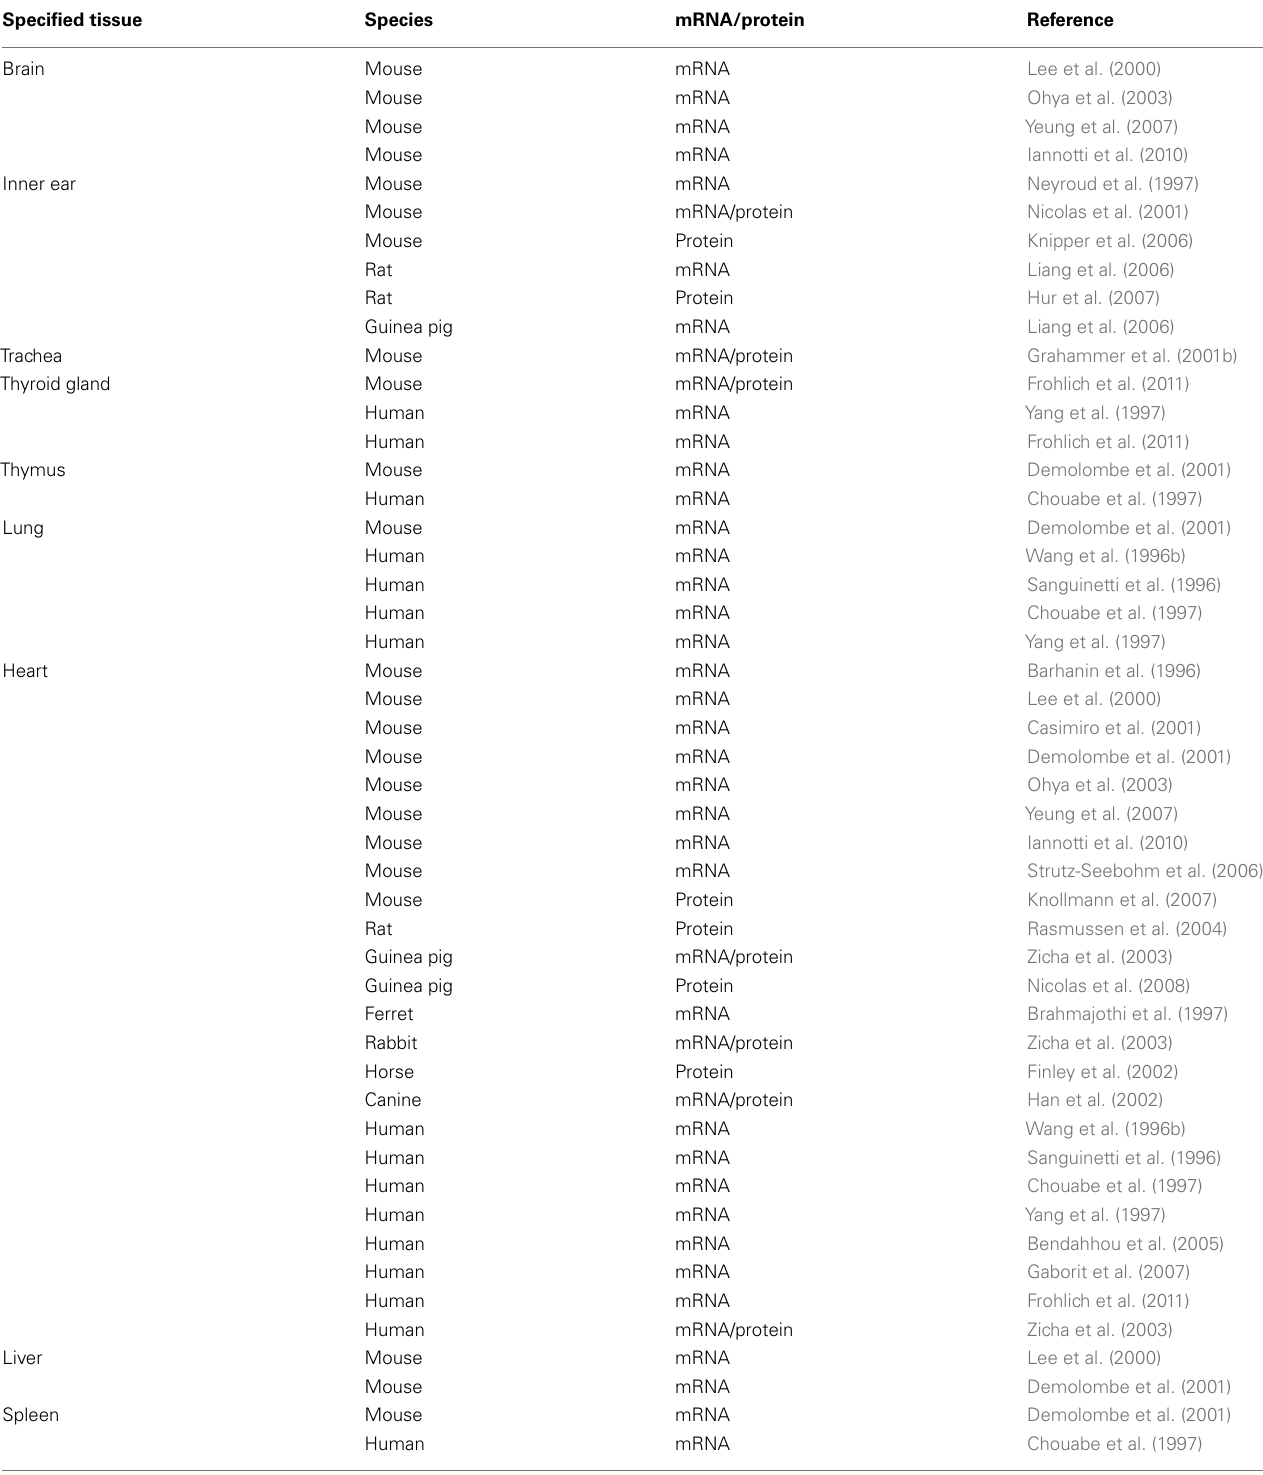
TableA1 | Kv7.1 expression in mammalian